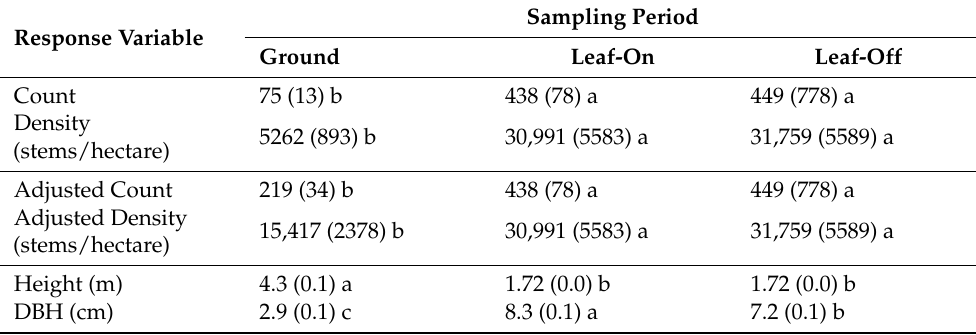
Table 1. Estimated means (and standard errors) of the generalized linear model output for the measured count, density, height, and DBH response variables measured. Lowercase letters represent significant differences ( α = 0.05) following pairwise comparisons. Adjusted values were calculated by adding the counted shrubs ( ≥ 1.3 m) to the tree values in the ground measurement.